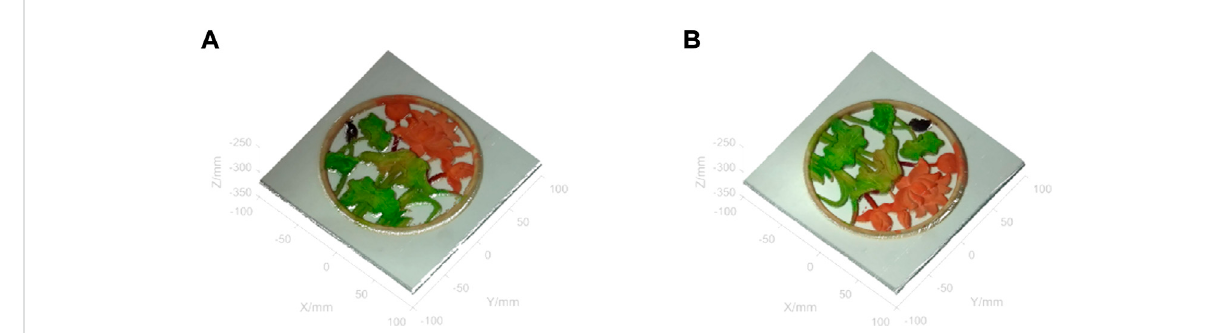
FIGURE 1 Registration of the fi rst two clusters of point